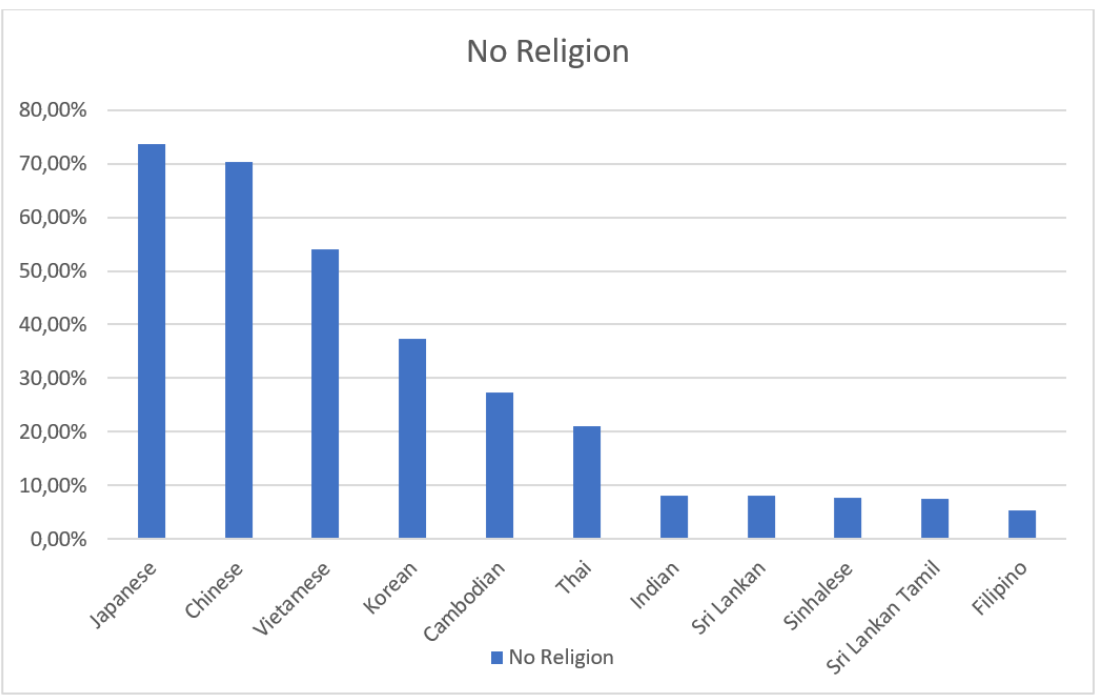
Figure 2: The percentage claiming “No Religion” among representative Asian groups (New Zealand Census, 2018). 8